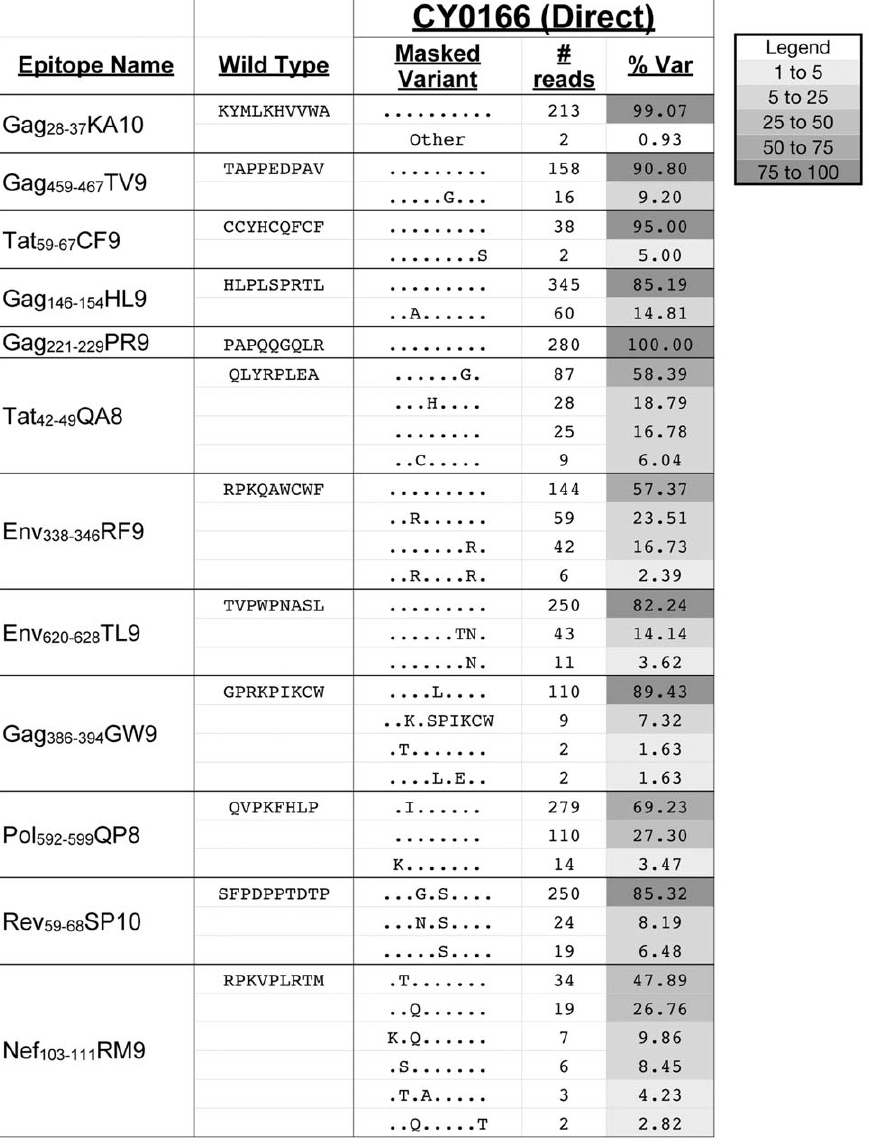
Figure 2. Sequence variants in CD8-TL epitopes are detectable by directly pyrosequencing virus populations isolated from CY0166. Amino acid variation detected by directly pyrosequencing the virus population in CY0166 is shown for all 12 CD8-TL epitopes. Sequences that match the inoculum are represented with a ‘‘.’’. The number of high quality reads with each specific sequence is shown. The total number of reads for each epitope can be found in Table S2. The frequency of reads with a specific amino acid sequence is shown as ‘‘% Var.’’ The sequences labeled as ‘‘other’’ include variants that were individually present at less than 1% and variants that were also detected in the inoculum. The relative shading of each box reflects the frequency of reads, as indicated in the